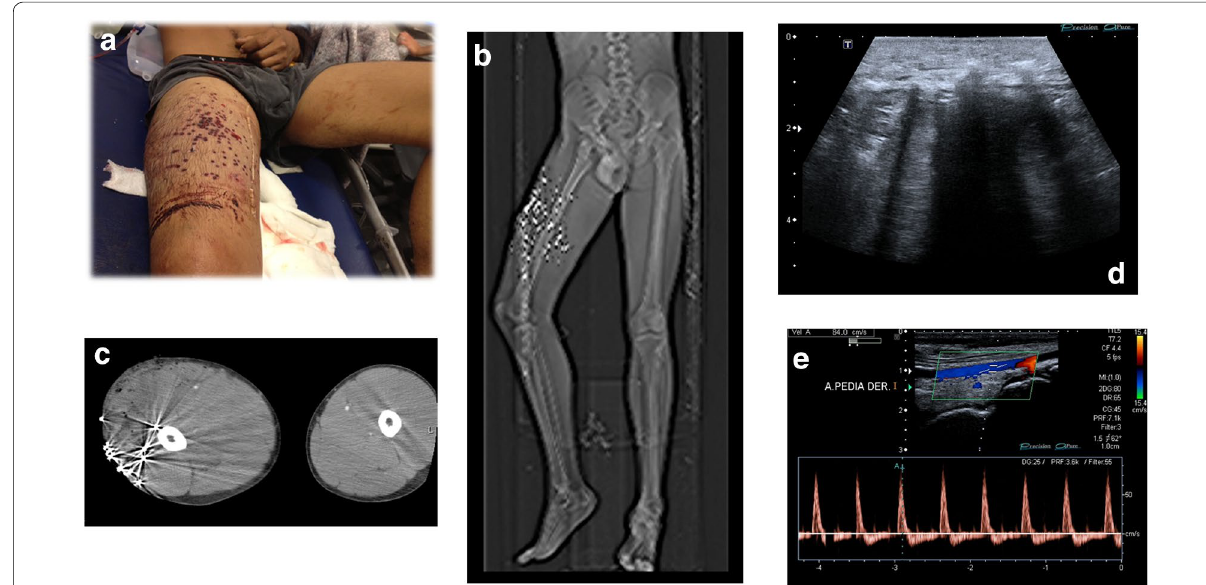
Fig. 20 External compression. a Multiple penetrating gun shot wounds in the right tight. b CT scan. c CT multiple bullets. Increase diameter of the right tight. d Ultrasound showed the metallic foreign bodies with acoustic shadow and edema of the soft tissues. e Color Doppler showed no vascular lesion in the right tight Pulse wave Doppler showed lost of the triphasic normal flow in distal arteries caused by external compression of the arteries cause by edema and